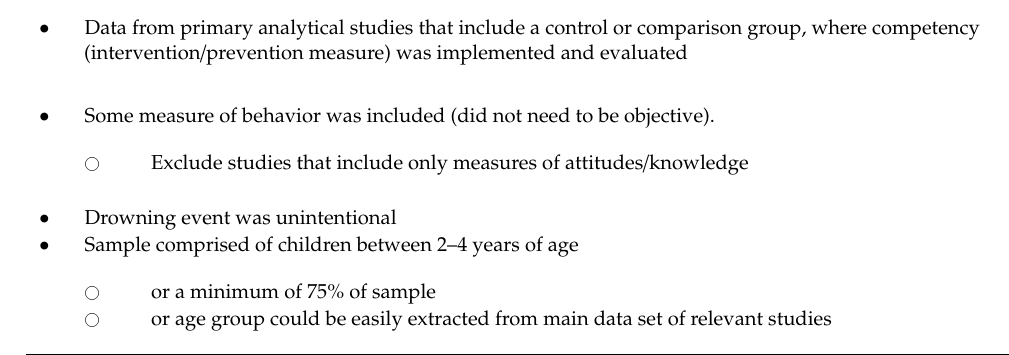
Table 1. Inclusion and exclusion criteria.